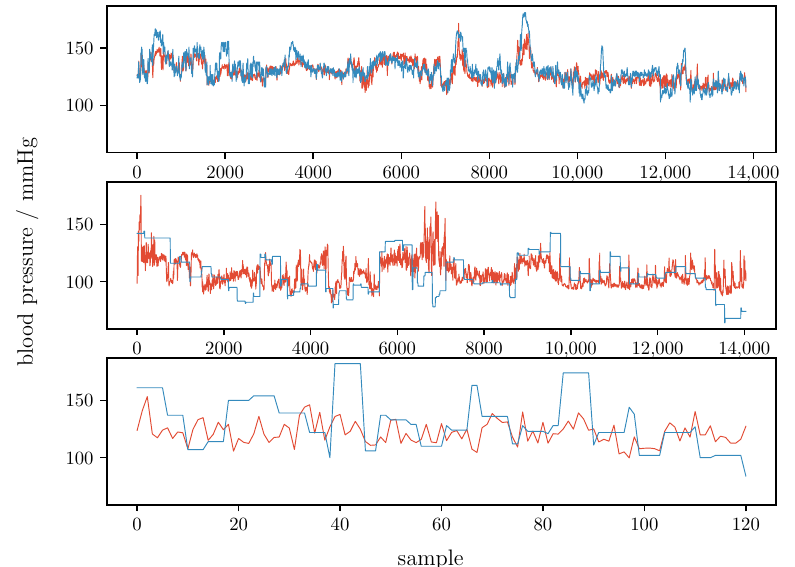
Figure 2. Comparison of estimated blood pressure (orange line) and ground truth (blue line) for all samples of the test set. The top plot shows the CPT data, the middle plot shows the Queensland data, the bottom plot shows the PPG-BP